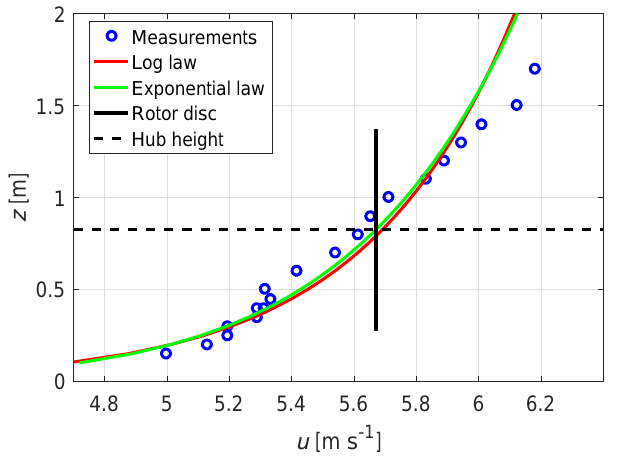
Figure 4. Vertical profile of the inflow velocity.